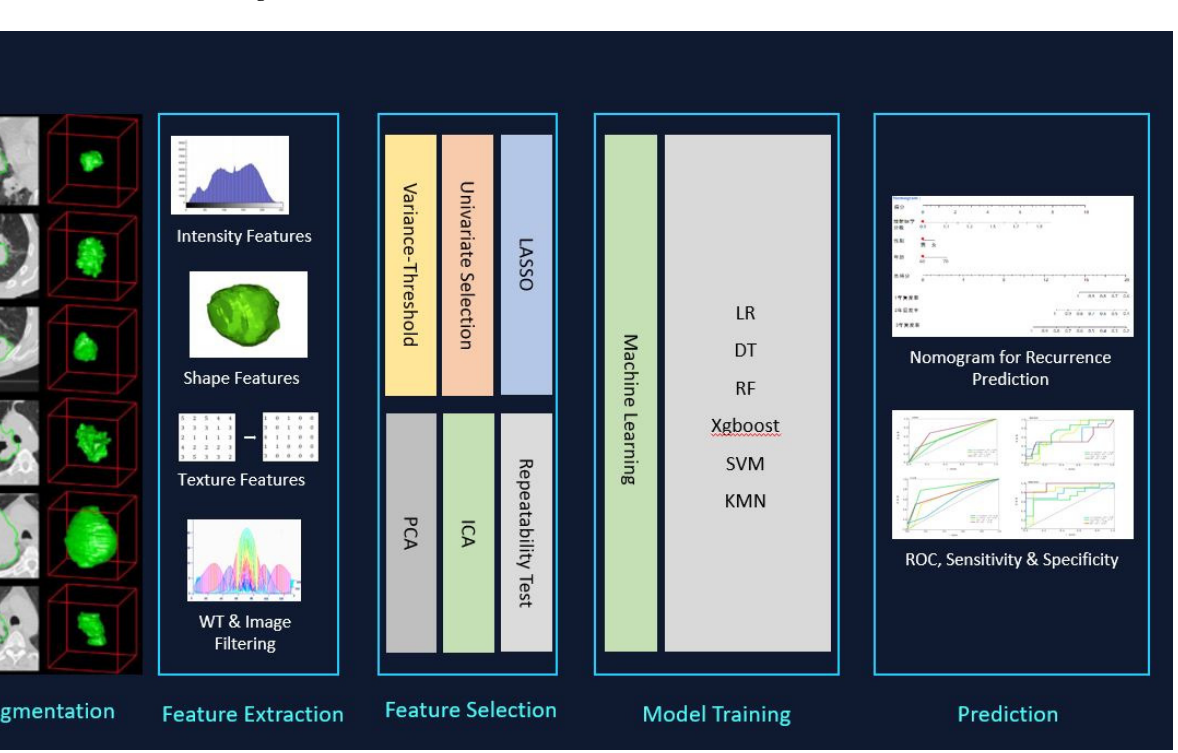
Figure 1. 3D segmentation, feature selection, and radiomics analysis of workflow used for PCTs and PHs.